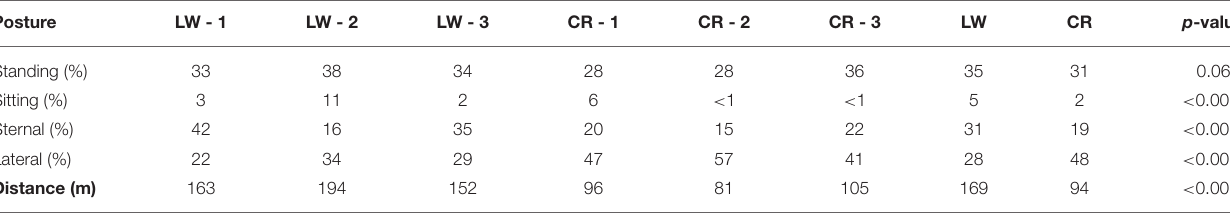
TABLE 4 | Comparison of the posture distribution and distance between the two breeds. Posture